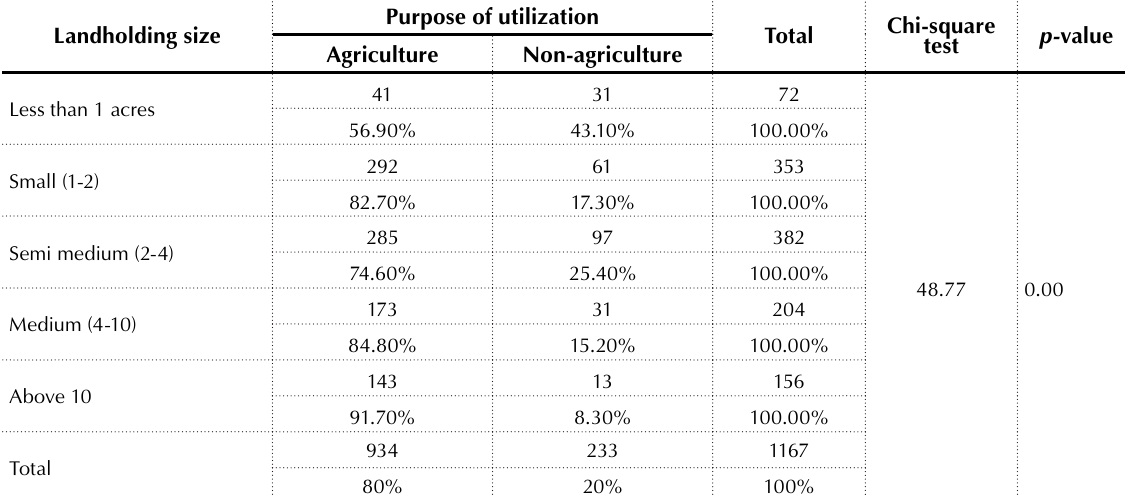
Table 11. Impact of the landholding size on the purpose of agricultural credit utilization